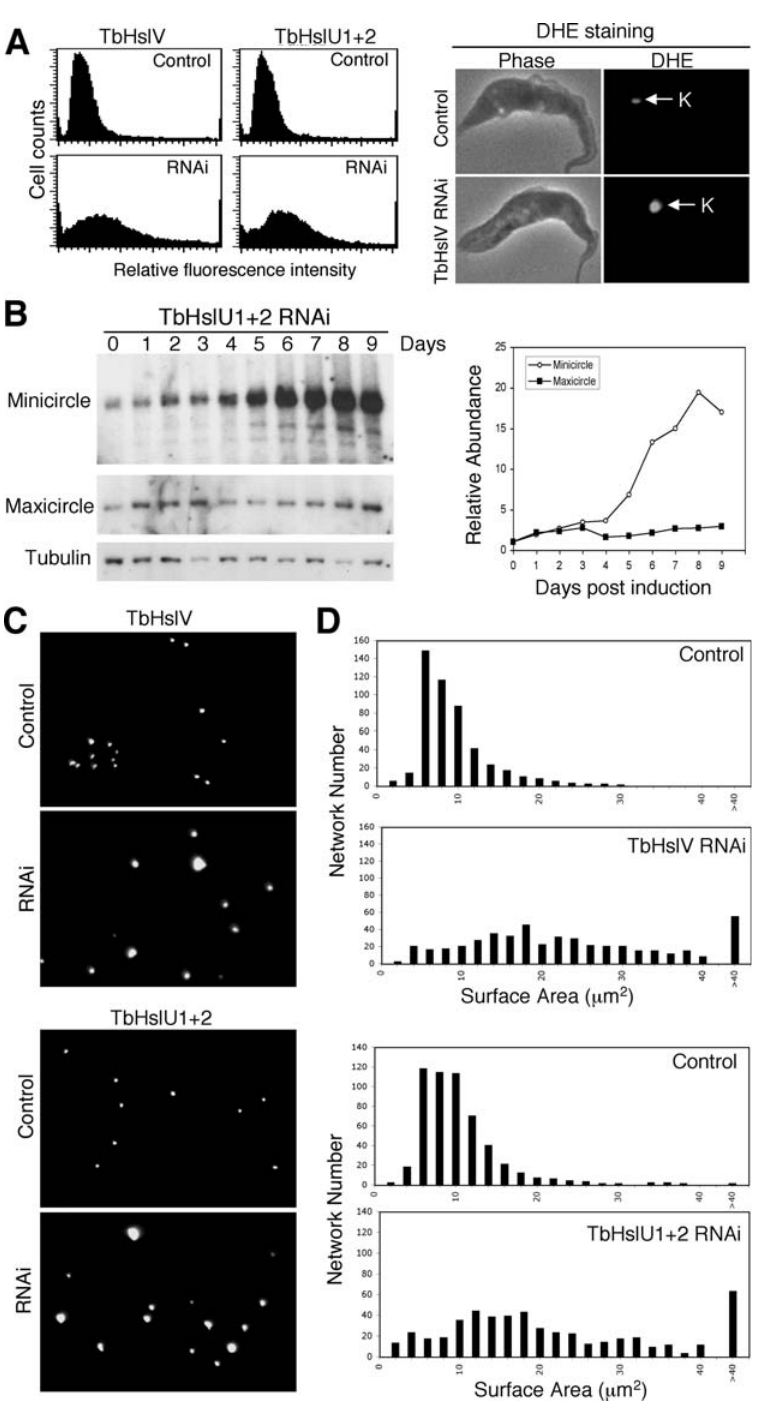
Figure 3. TbHslVU RNAi led to heterogeneously sized kinetoplasts. ( A ). Flow cytometry analysis of DHE stained cells. A total of 25,000 cells were counted in each experiment (Left panel). DHE stains exclusively the kinetoplasts in control and RNAi cells (Right panel). ( B ). Southern analysis of changes in minicircle and maxicircle DNA content during TbHslU RNAi. The kinetics of minicircle (open circle) and maxicircle (filled square) accumulation are presented to the right of the Southern blots. ( C ). DAPI staining of the isolated kDNA networks. ( D ). Surface areas of the isolated kDNA networks stained with DAPI, and measured with the NIH Image software.